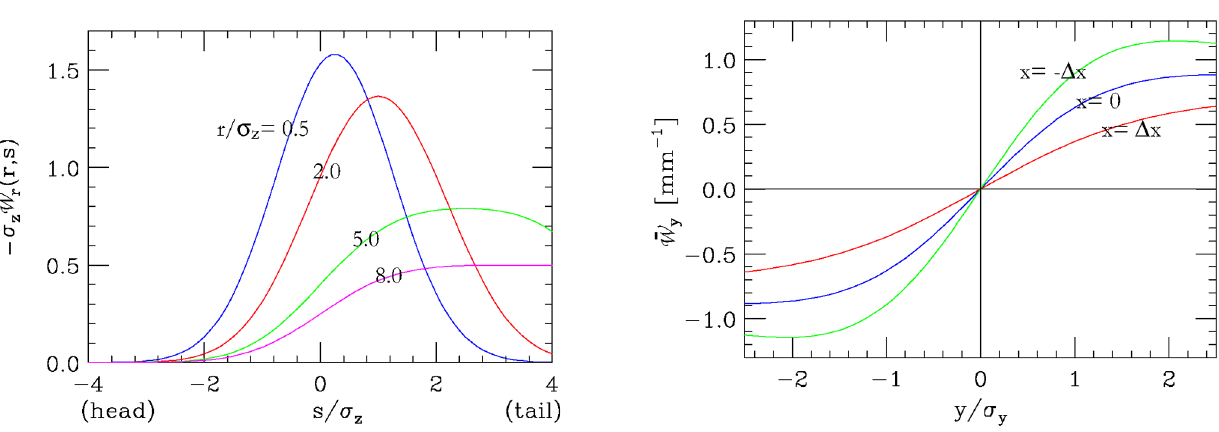
vs y , for x (cid:7) y